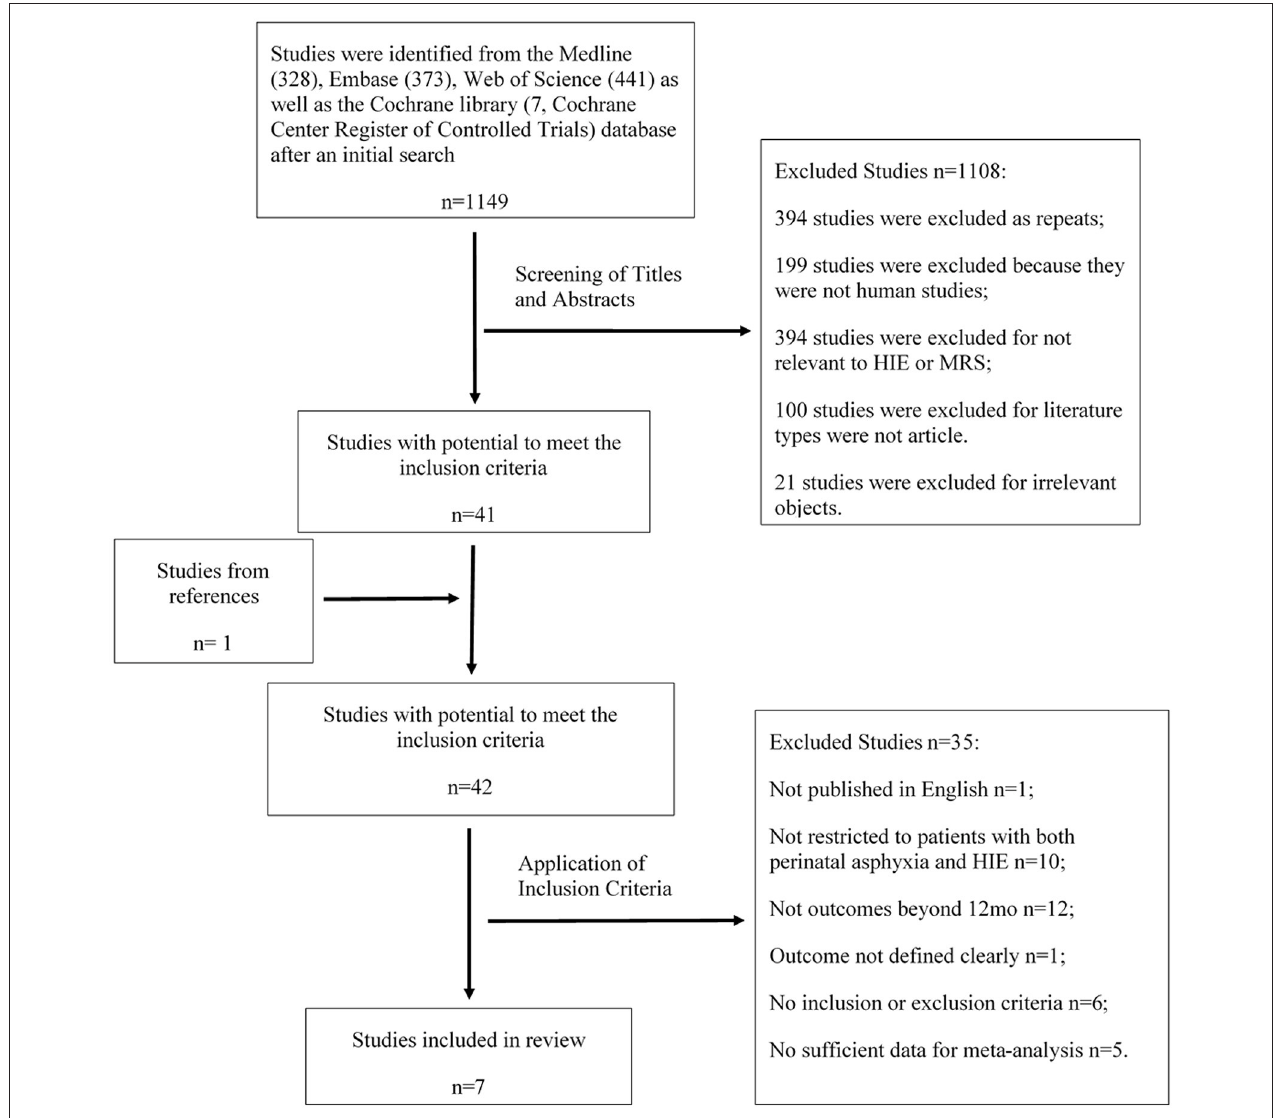
FIGURE 1 | Study selection process. The flow chart shows the procedure of literature search and study inclusion and reasons for